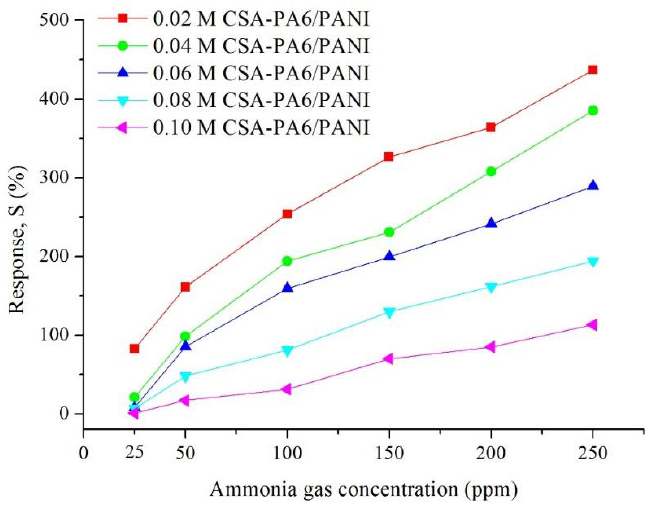
Figure 8. Response of the CSA-doped PA6/PANI composite nanofibers for 25–250 ppm NH 3